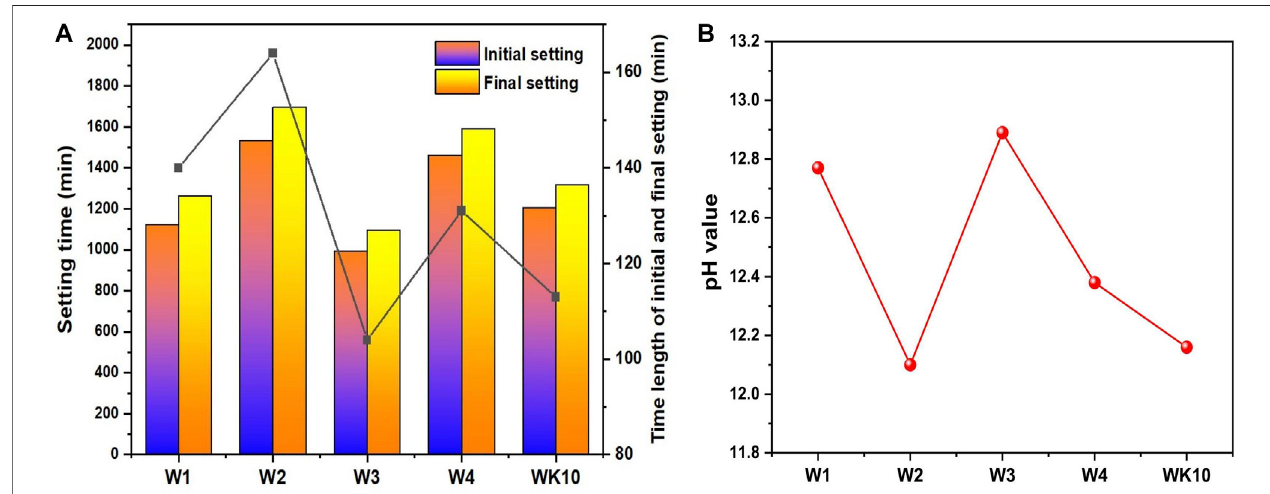
FIGURE 5 | (A) Initial and fi nal setting times and (B) pH value of P-SSC